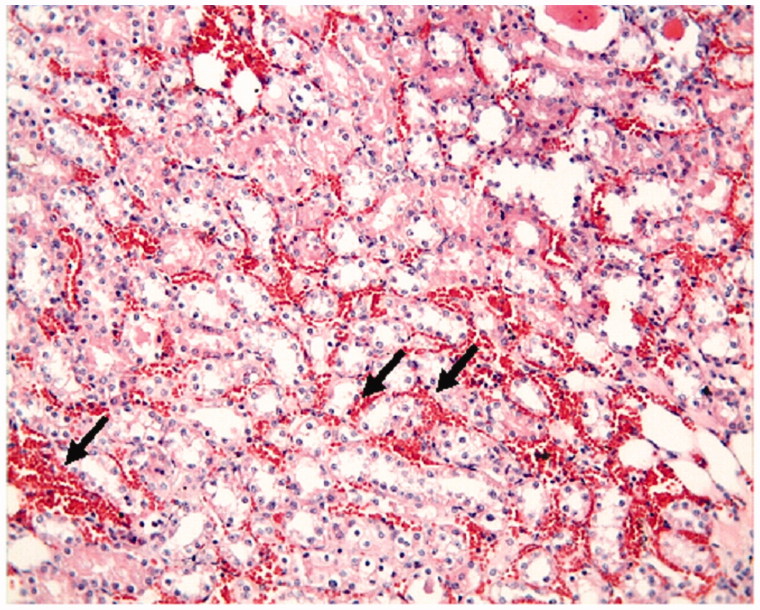
I/R + HP group: intertubular congestion obvious (arrow), H–E; ×20.